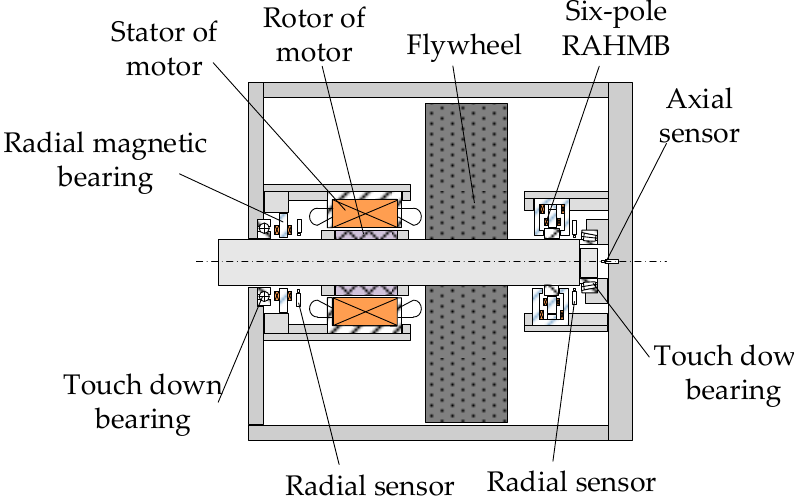
Figure 1. The structure diagram of six-pole RAHMB suspended flywheel. The six-pole RAHMB consists of axial stator, radial stator, PM, rotor, radial control coils and axial control coils, as shown in Figure 2a. The PM is annular and magnetized along the radial direction. The biased flux generated by PM flows out from the outer torus and then flows into the axial stator. The axial stator is composed of one cylinder, two discs and two annular axial magnetic poles. The biased flux flows from axial magnetic poles into the axial air gap between the rotor and axial stator, flows through the radial air gap and radial stator, and finally flows back to the inner torus of PM. The vector diagram of flux path in the six-pole RAHMB is shown in Figure 2b. The radial control flux generated by radial control coils flows in the loop of radial stator, radial air gap and rotor. The axial control flux generated by axial control coils flows in the loop of axial stator, axial air gap and rotor. The radial/axial control flux and the biased flux are superimposed in one radial/axial air gap and are offset in the opposite radial/axial air gap; thus, the suspension forces along the radial/axial magnetic poles are generated.